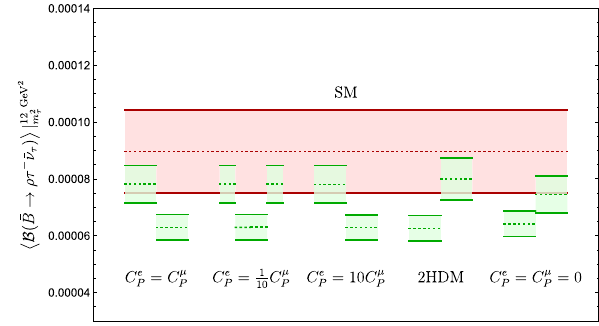
Fig. 19 Illustration of the possible values that B ( ¯ B → ρτ − ¯ ν τ ) may take for the scenarios discussed in the text. The red horizontal band gives the SM value, whereas the green regions indicate the values of the branching ratio that may be